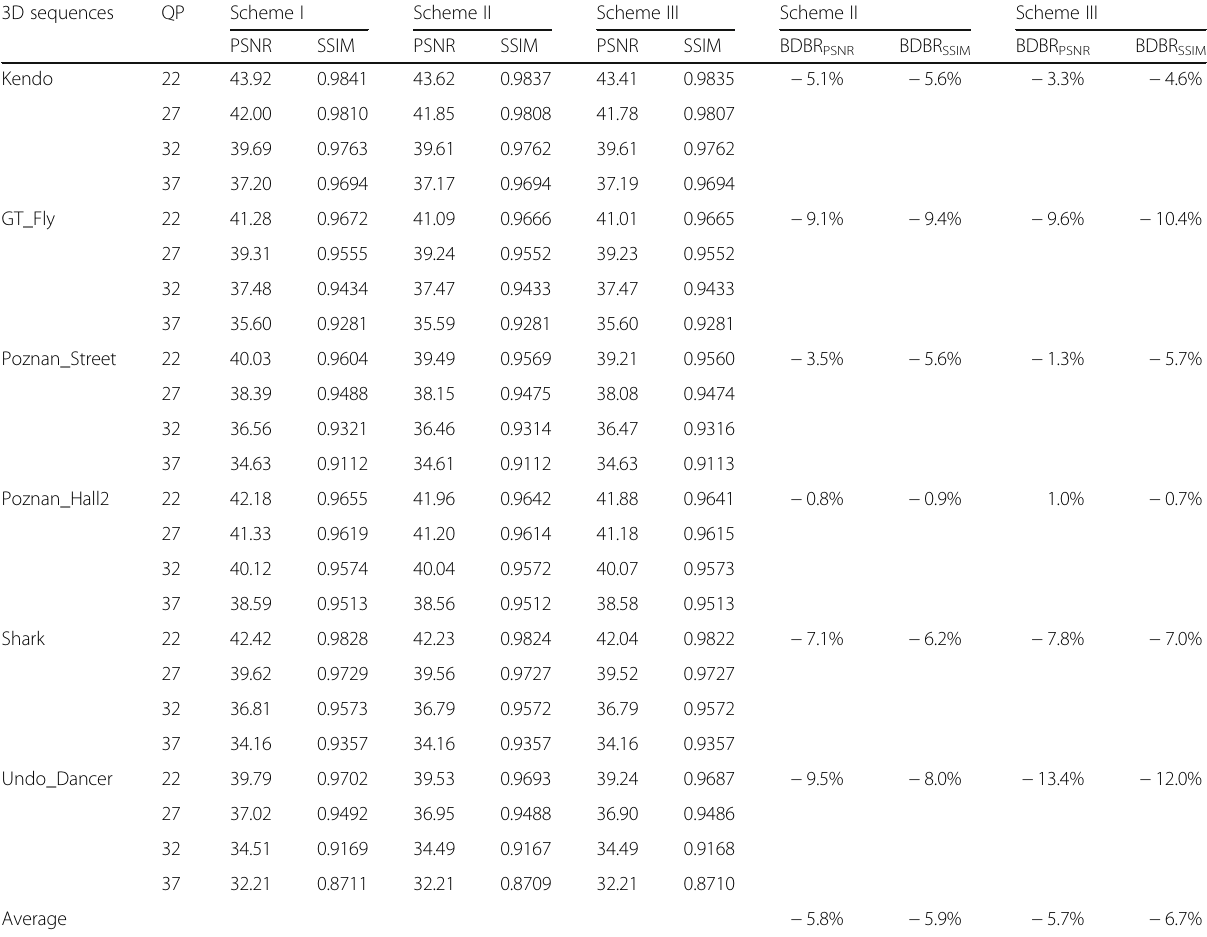
Table 13 SSIM value of six reconstructed video sequences under different QP 3D